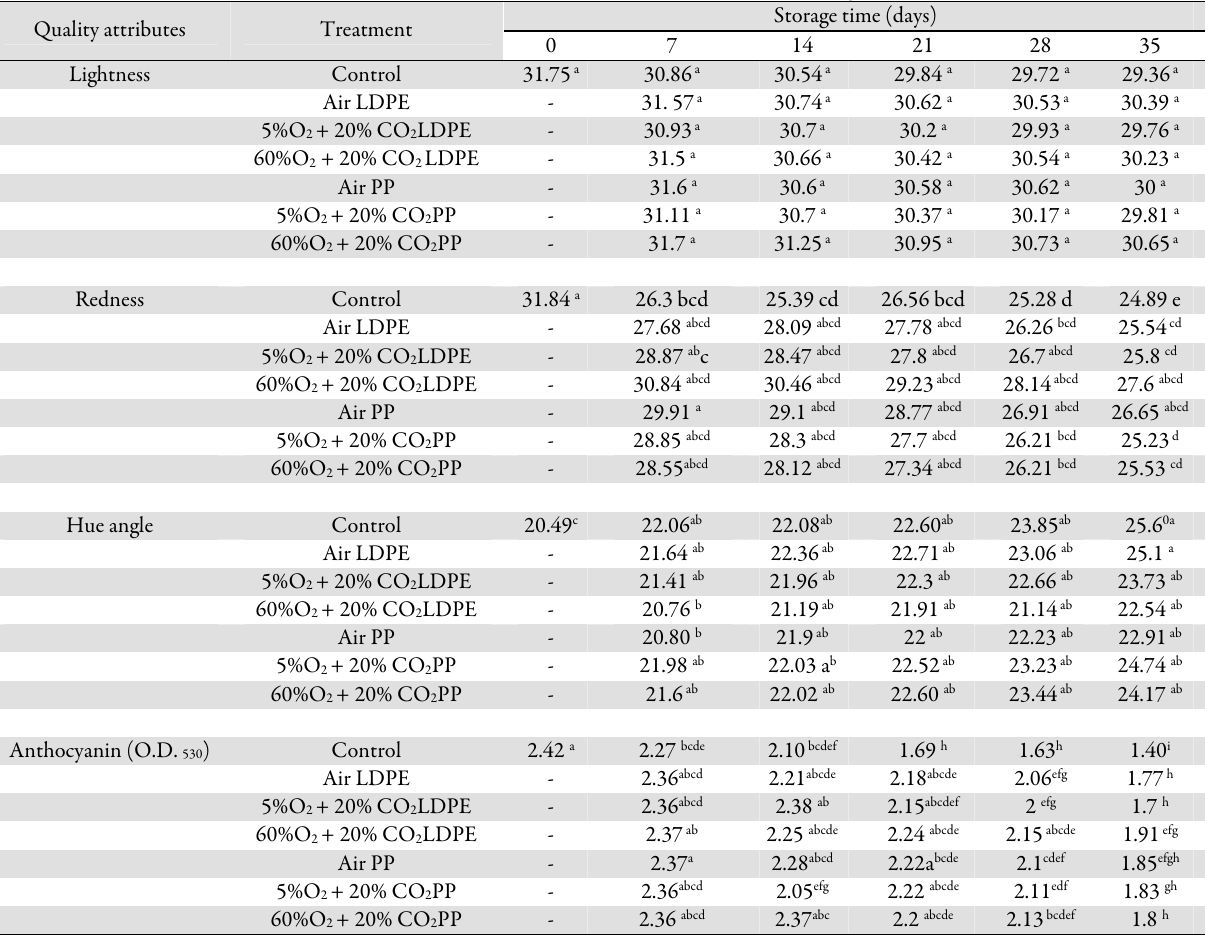
Table 3. Changes in color parameters ( L * , a * , h ˚ ) and anthocyanin index of cornelian cherry fruits before (day 0) and after 5 weeks of storage at 1 °C packaged in two types of polymeric films: LDPE- low density polyethylene , PP- polypropylene using three gas